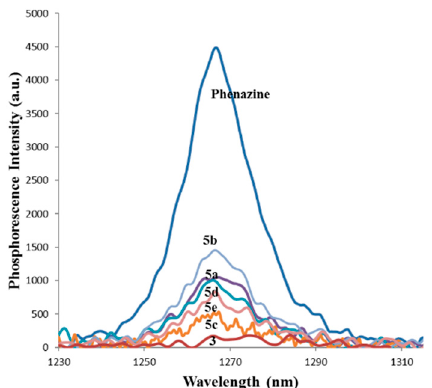
Figure 2. Singlet oxygen emission spectra of unsubstituted squaraine 3 and aminosquaraines 5a – e in CHCl 3 against the reference compound (phenazine).